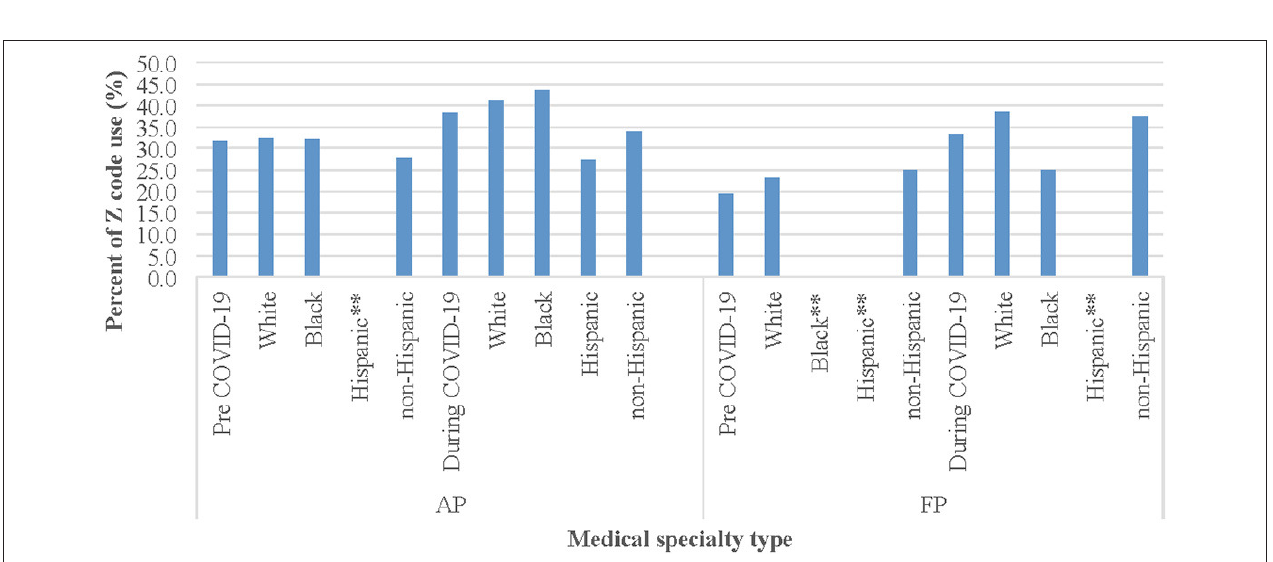
FIGURE 3 | Z code use among racial and ethnic groups before and during COVID-19 by visit type. Note: ER = emergency room visit; IP = inpatient visit; OP = outpatient visit.